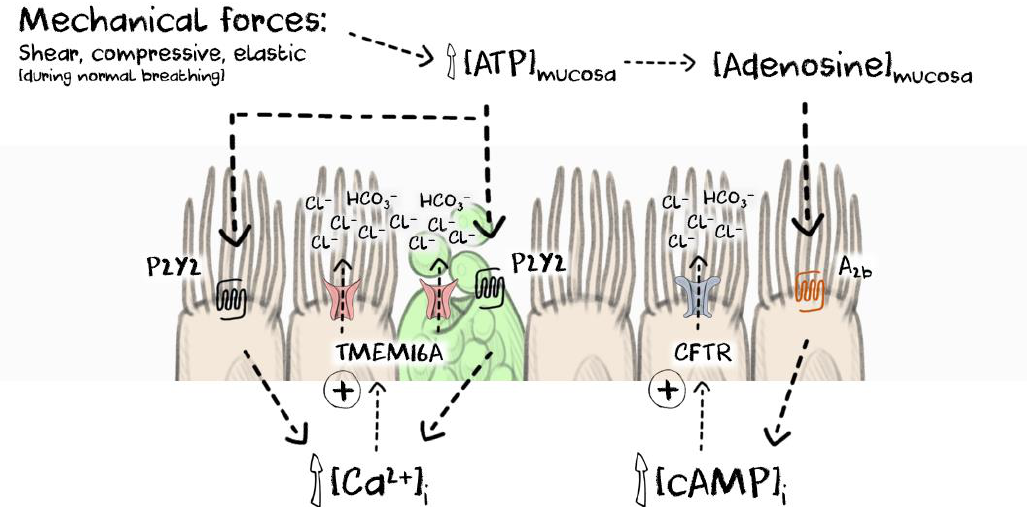
Figure 2. The current model describing the local regulation of calcium-dependent signalling in the human airway epithelium. Endogenous ATP is released from epithelial cells in the airways during normal breathing and is regulated by compressive, elastic and shear forces. ATP binds to P2Y2-receptors and elevates local [Ca 2 + ] i leading to activation of TMEM16A and CFTR to promote anion and fluid secretion and also enabling goblet cell exocytosis to provide mucins to form the mucus gel. ENaC function is also attenuated when intracellular calcium is elevated (not shown for clarity). Mucosal ATP is also metabolised to adenosine and can further activate CFTR through an adenosine A2b-cAMP mediated pathway. As the rate and depth of breathing increase, ATP levels rise to promote fluid secretion to compensate for evaporative loss and to provide an increased quantity of a well-hydrated mucus gel to clear the increased burden of inhaled particles. [cAMP] i = intracellular